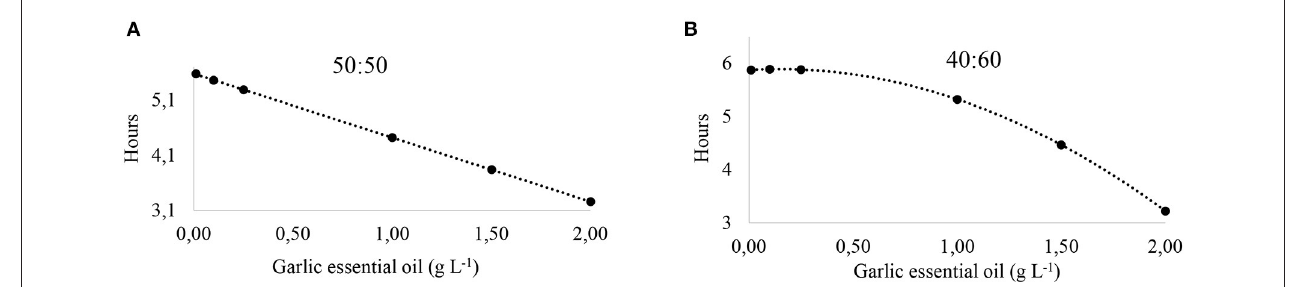
FIGURE 3 | Microorganism colonization time in diets having different roughage:concentrate ratios (50:50 and 40:60) with addition of garlic essential oil. (A) y = − 1.15911x + 5.57709; P : 0.0001; R 2 : 0.57; (B) y = − 0.77310x 2 + 0.21759x + 5.88025; Maximum point: 0.14; P : 0.0001; R 2 : 0.60. P , Probability; R 2 , Determination